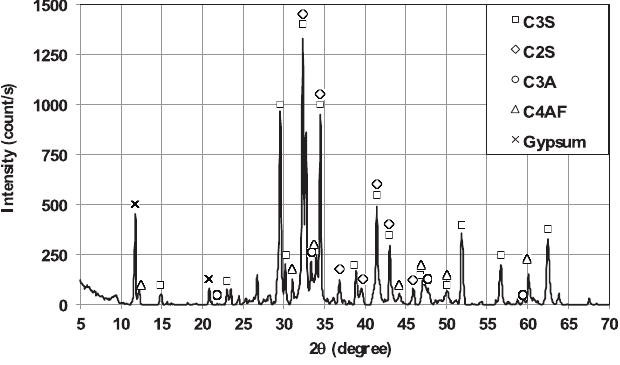
Portland cement